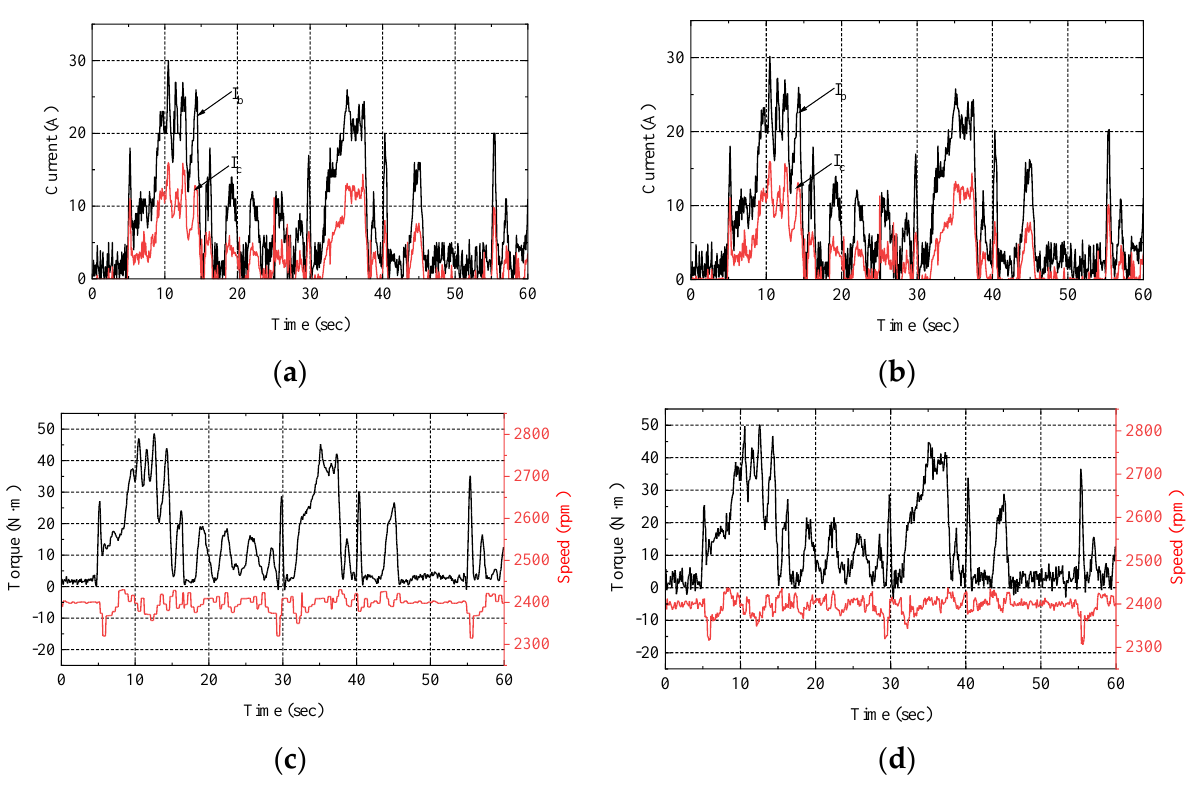
Figure 13. The HES performance of an electric loader during the start process. ( a ) Currents of the robust controller. ( b ) Currents of the PI controller. ( c ) Torque and speed of the robust controller. ( d ) Torque and speed of the PI controller.